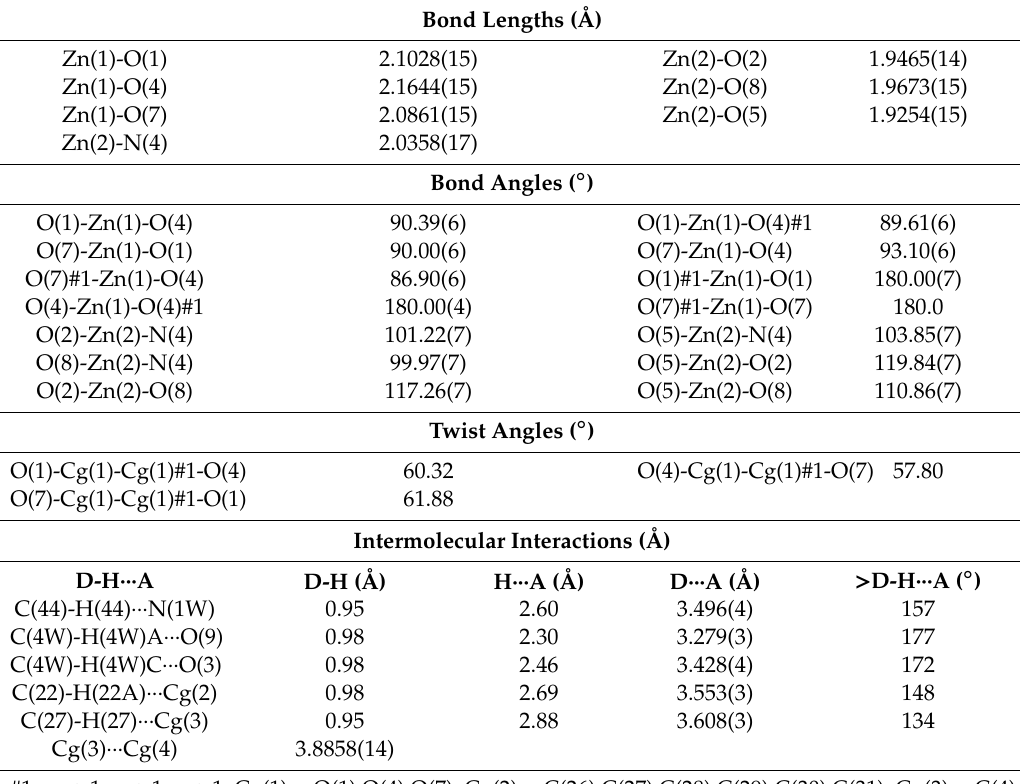
Figure 4. Molecular structure of complex: ( a ) 2 · 4CH 3 CN and ( b ) 3 · 4EtOH. ( c ) N-H ··· O intramolecular interactions of the ACA ligands in 2 · 4CH 3 CN and 3 · 4EtOH with labels assigned for complex 3 · 4EtOH. The phenyl and other atoms which do not participate in any of the mentioned interactions have been omitted for clarity. Table 2. Selected bond lengths (Å), bond angles ( ◦ ), and intermolecular interactions (Å) of compound 2 · 4CH 3